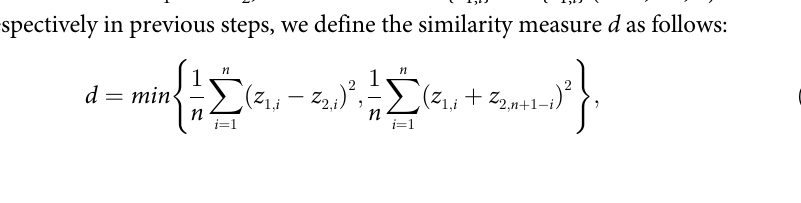
in each feature set. i